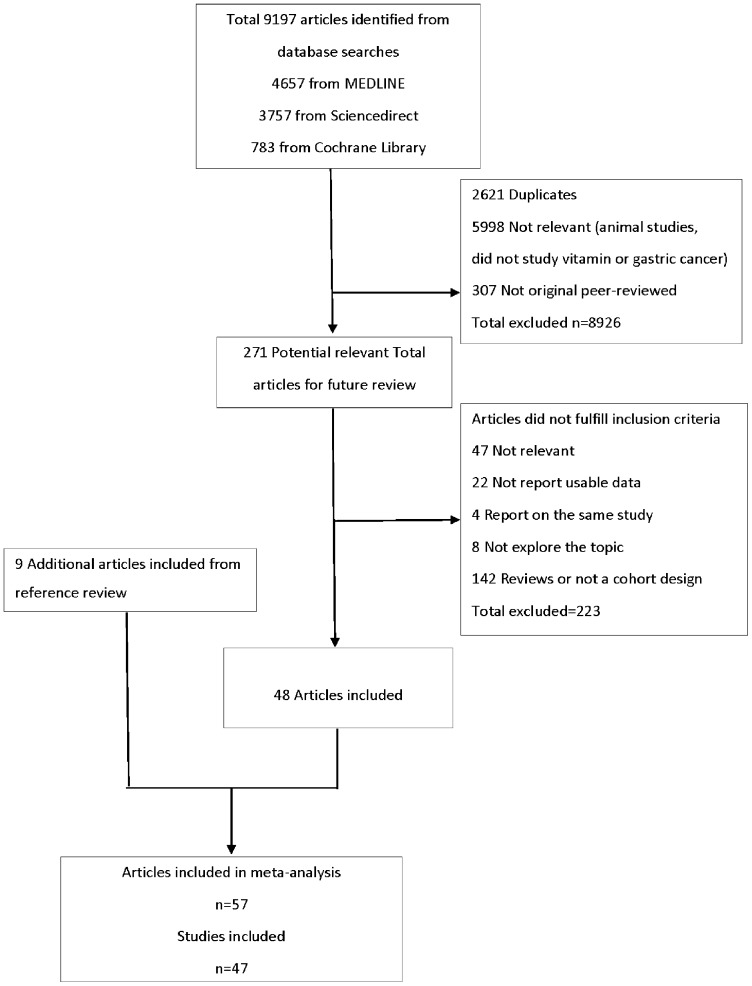
Flow Diagram of Study Selection.